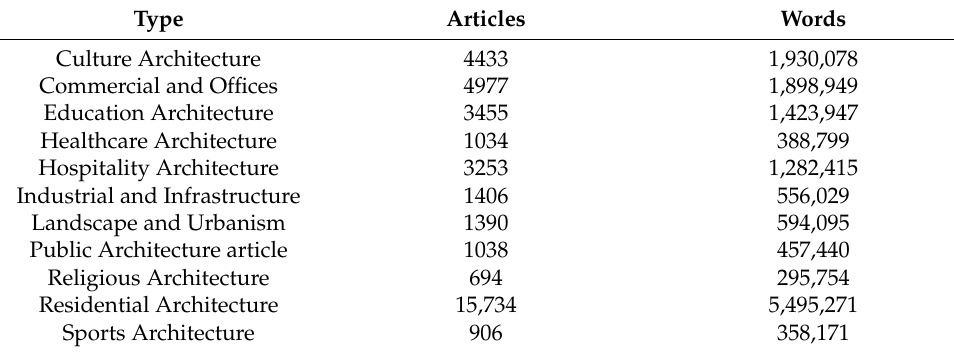
Table 1. Text corpus information statistics.